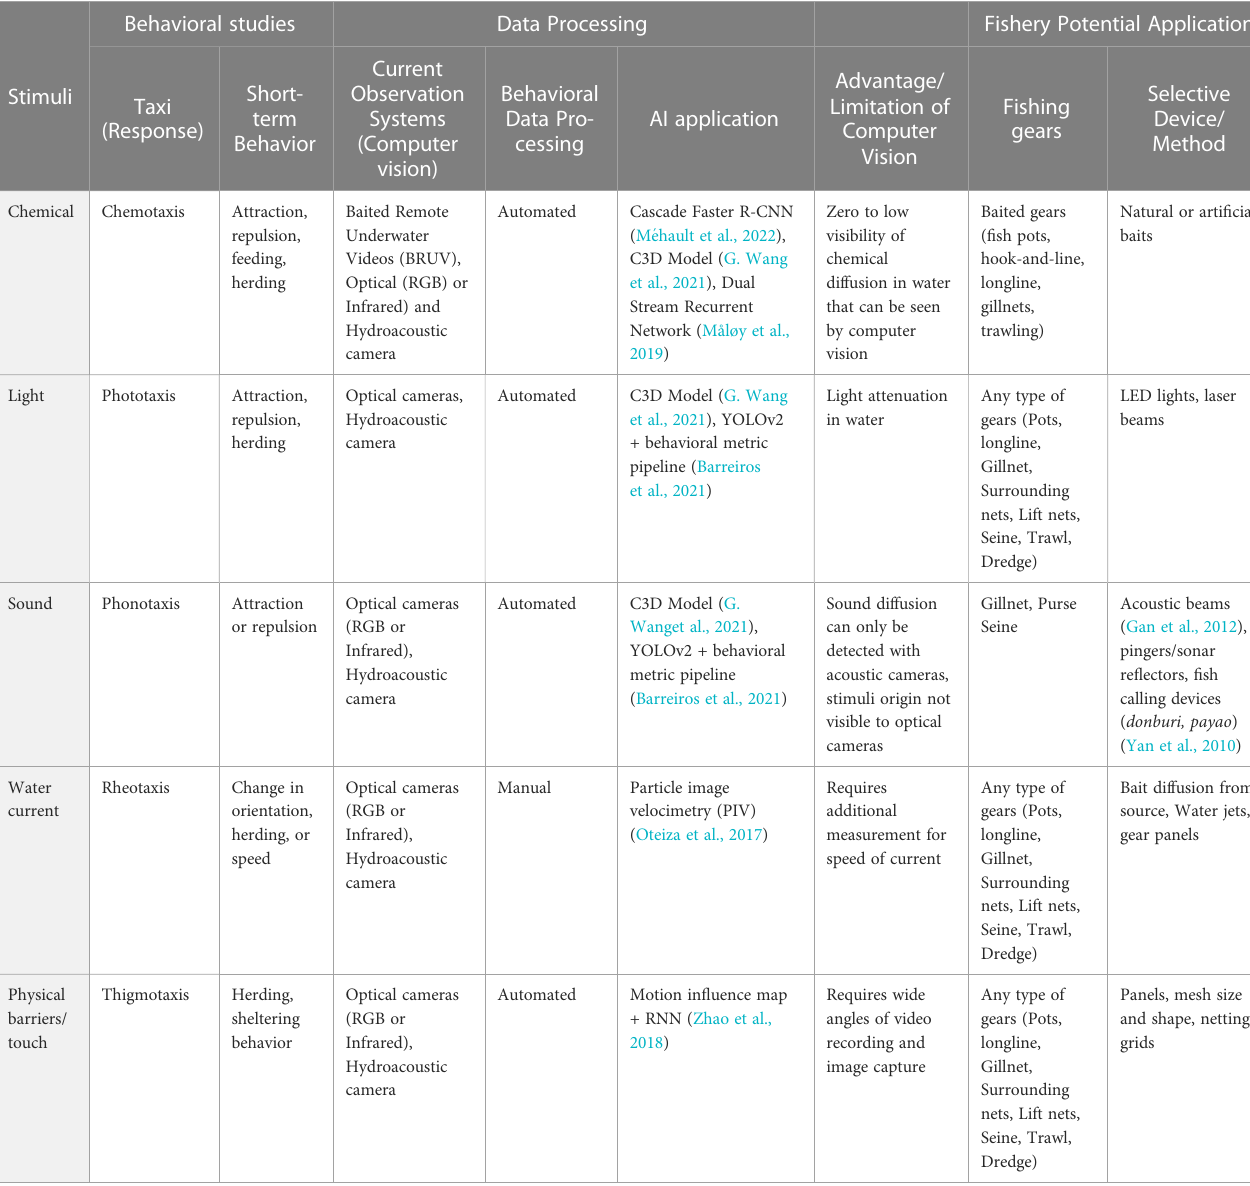
TABLE 2 Examples of fi sh behavior studies exploring species ’ responses to stimuli using AI and their application on fi